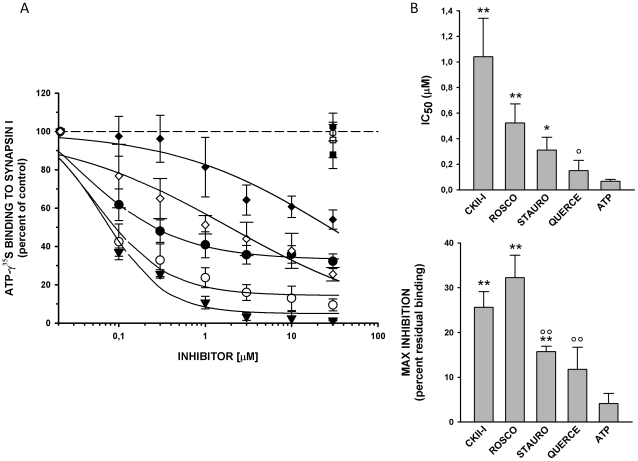
Binding of distinct ATP-competitors to the ATP-binding site of bovine synapsin I.A. Inhibition curves of ATP-γ35S (0.2 µM) binding to purified bovine synapsin I (0.5 µM) by increasing concentrations of either cold ATP (closed triangles), quercetagetin (open circles), roscovitin (closed circles), H-89 (closed diamond), 7015980251 (open diamond), R59022 (open hexagon), CCT018159 (closed hexagon), 4072–2730 (open square) and novobiocin (closed square). The amount of ATP-γ35S bound in the presence of the inhibitors is expressed in percent of the binding under control conditions (absence of either inhibitor). Points in the plot are means ± sem from 5 independent experiments. Inhibition curves were fitted using a 3-parameter sigmoidal dose-response function. B. IC50 (upper panel) and lower plateau (lower panel) values were calculated from individual curve fittings and are shown as means ± sem from 5 independent experiments. The values of H-89 (IC50 >30 µM) and the inactive compounds (R59022, CCT018159, 4072–2730 and novobiocin) are not reported. Statistical analysis was carried out by one-way Anova followed by the post-hoc Bonferroni's multiple comparison test (* p<0.05, ** p<0.01 vs ATP ; ° p<0.05, °° p<0.01 vs roscovitin). CKII-I, 70159800251; QUERCE Quercetagetin; ROSCO, (R)-Roscovitin; STAURO, Staurosporine.